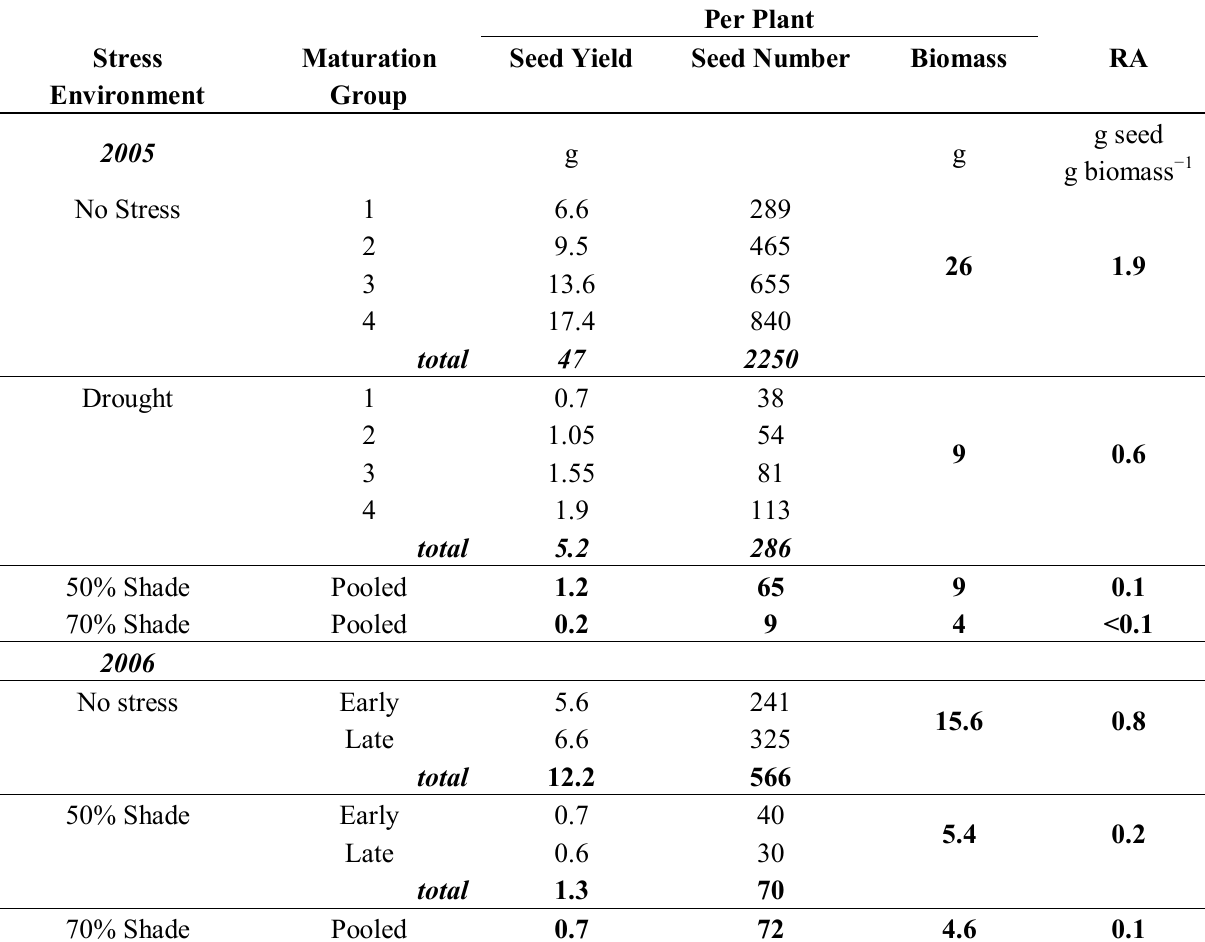
Numbers in bold represent total values for each stress